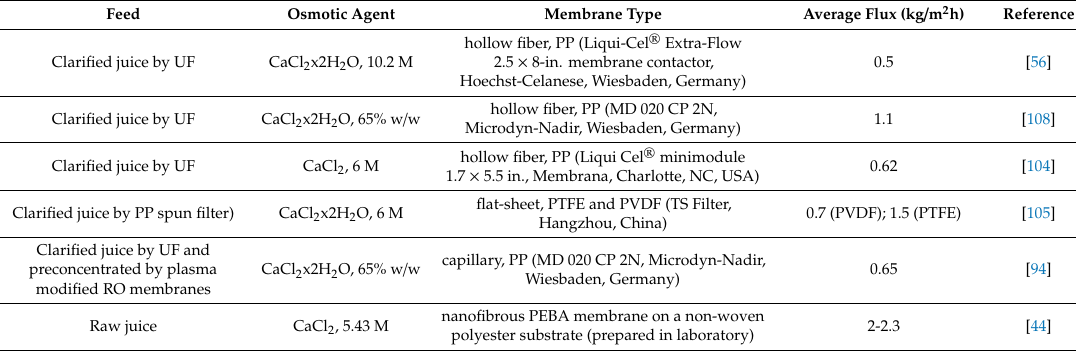
Table 4. Concentration of pomegranate juice by osmotic